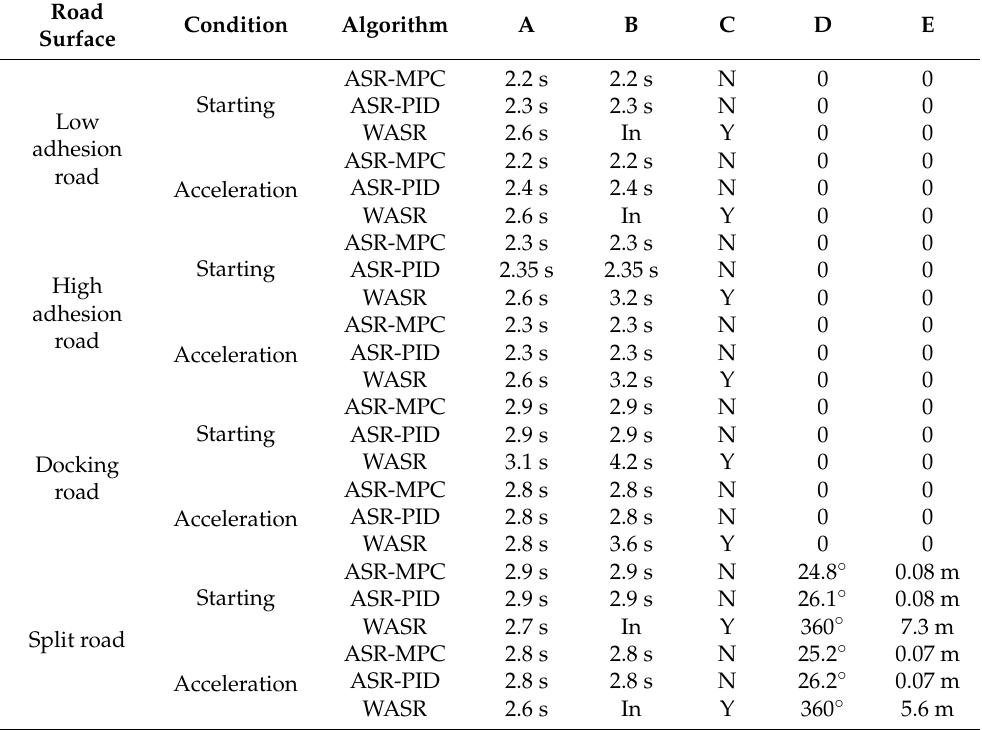
Table 3. A comparison of the simulation results.